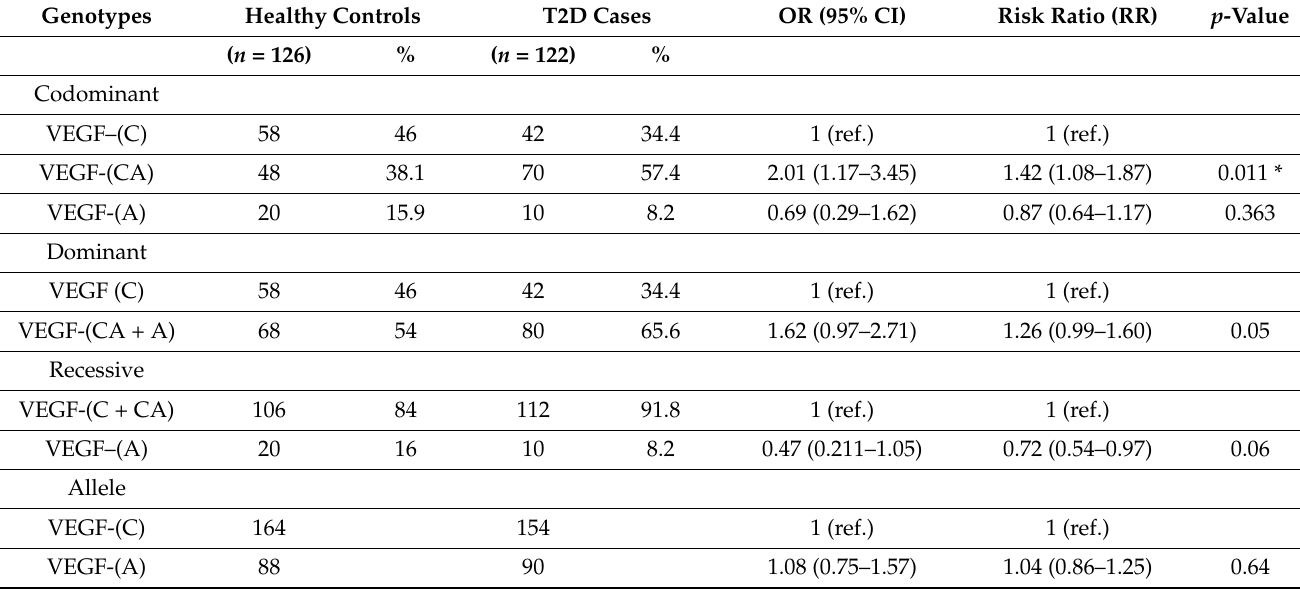
Table 6. Association of VEGF rs699947 C/A SNP with T2D.